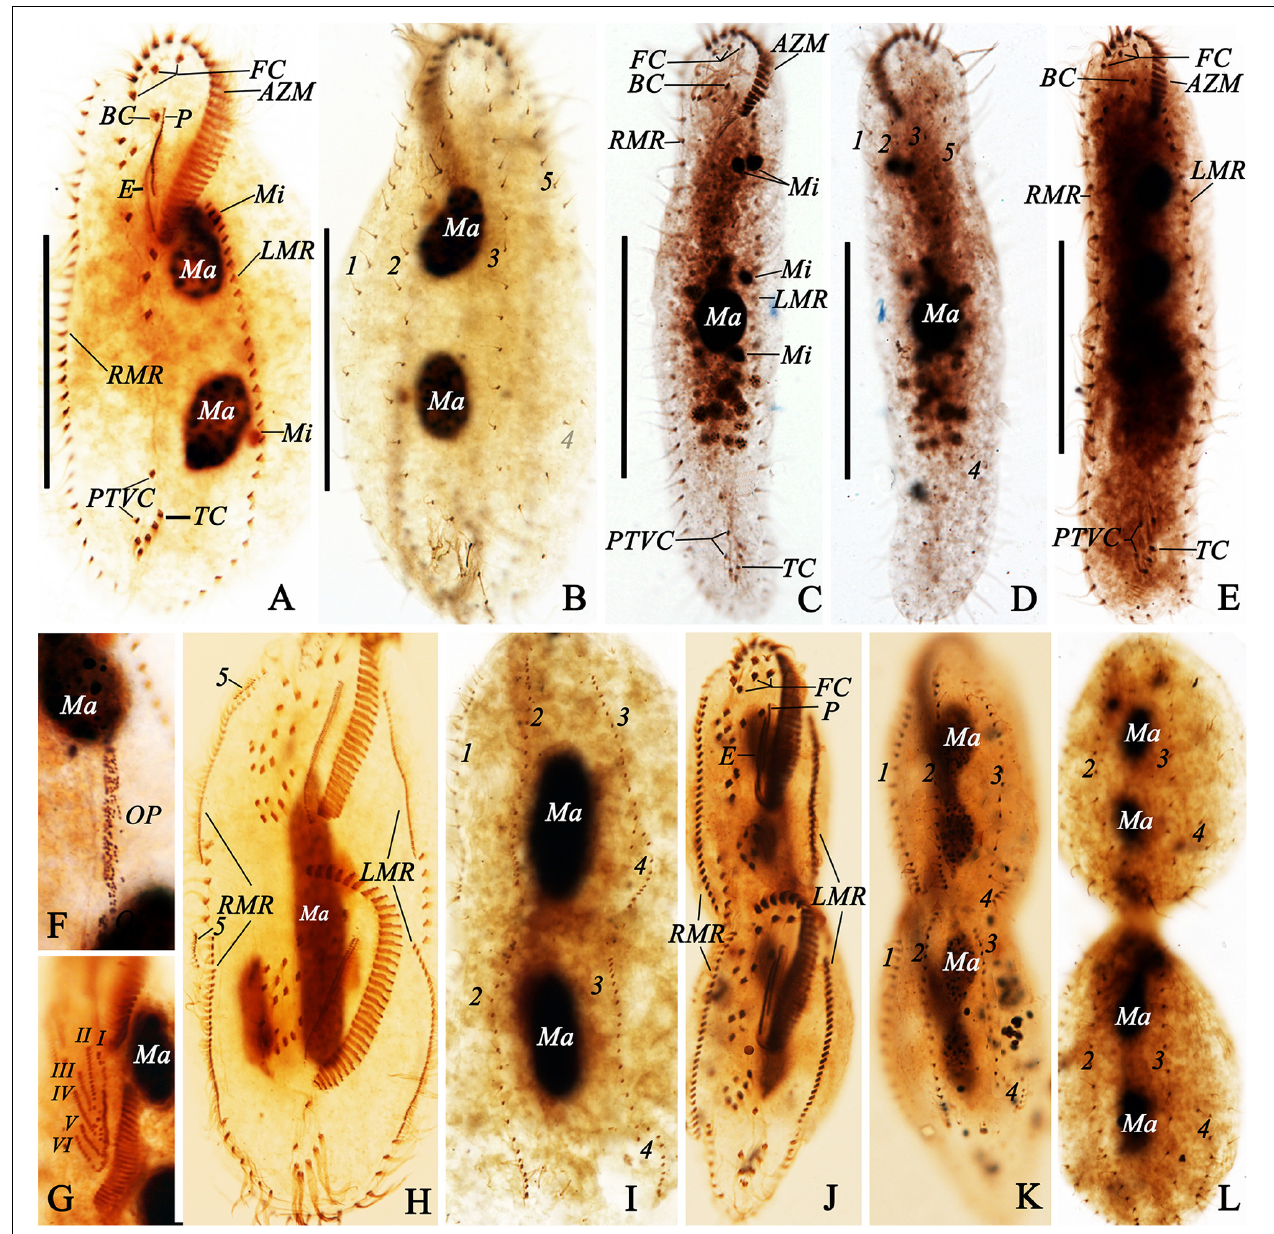
FIGURE 3 | Ciliature of normal (A,B) and abnormal (C–E) forms, and the morphogenesis (F–L) of Oxytricha granulifera granulifera after protargol staining. (A,B) Ventral and dorsal views of a normal specimen. (C–E) Ventral (C,E) and dorsal (D) views of abnormal specimens. (F) Ventral view of a very early stage to show the newly formed oral primordium. (G) Partial view of an early divider showing the six streaks (anlagen I–VI) of the opisthe. (H) Ventral view of a middle divider, to show the development of marginal cirri anlagen and the fused macronucleus. (I) Dorsal view of a divider showing the newly formed dorsal kineties 1–4. (J,K) Ventral (J) and dorsal views (K) of a late divider, to show the newly formed cirri and the origin of dorsal kinety 4. (L) Dorsal view of a very late divider which is about to divide. AZM, adoral zone of membranelles; BC, buccal cirri; E, endoral; FC, frontal cirri; LMR, left marginal cirri row; Ma, macronuclear nodules; Mi, micronuclei; OP, oral primordium; P, paroral; PTVC, pretransverse ventral cirri; RMR, right marginal cirri row; TC, transverse cirri. 1–4, dorsal kineties; 5, dorsal marginal kinety. Scale bars = 50 µ